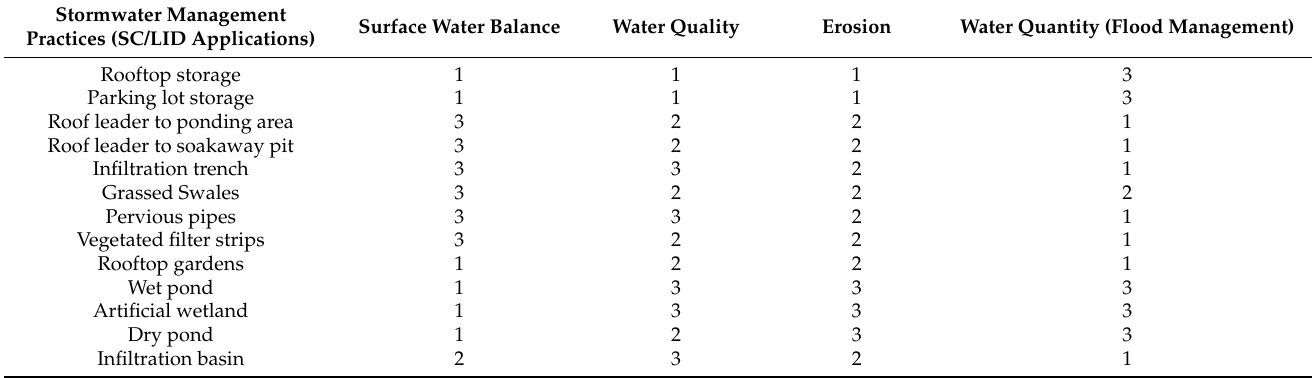
Table 1. Selected stormwater management practices (1: low suitability, 2: medium suitability, 3: high suitability); adapted from CVC and TRC, 2010